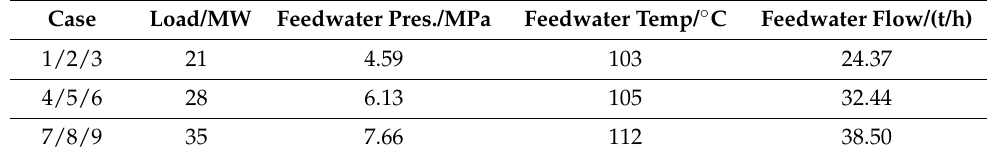
Table 3. Operation parameters during the mode